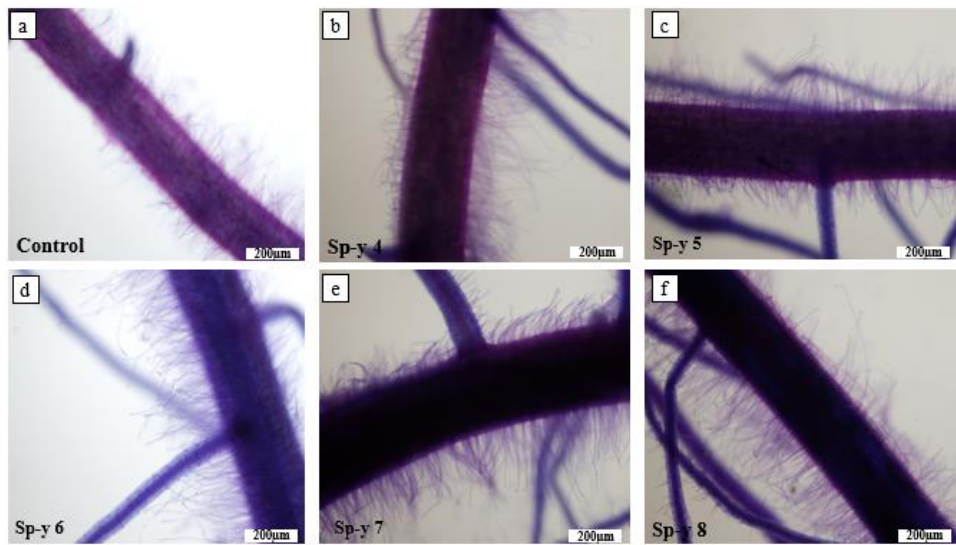
Figure 4. Effects of S. yanoikuyae SJTF8 at different CFU/mL concentrations on development of root hairs of 10-day-old rice seedlings. We stained the rootlets of the seedlings to make the root hairs visible. ( a ) Root hairs of 10-day-old seedlings under control. ( b ) Treatment effect showing visible increase in the root hair of seedlings treated with SP-y 4; ( c ) Treatment effect showing an increase in the density of root hair seedlings treated with SP-y 5; ( d ) Treatment effect showing a notable increase in the root hair length of seedlings treated with SP-y 6; ( e ) Visual observation of the root hair of rice seedlings treated with SP-y 7; ( f ) The root hair of rice seedlings treated with SP-y 8.